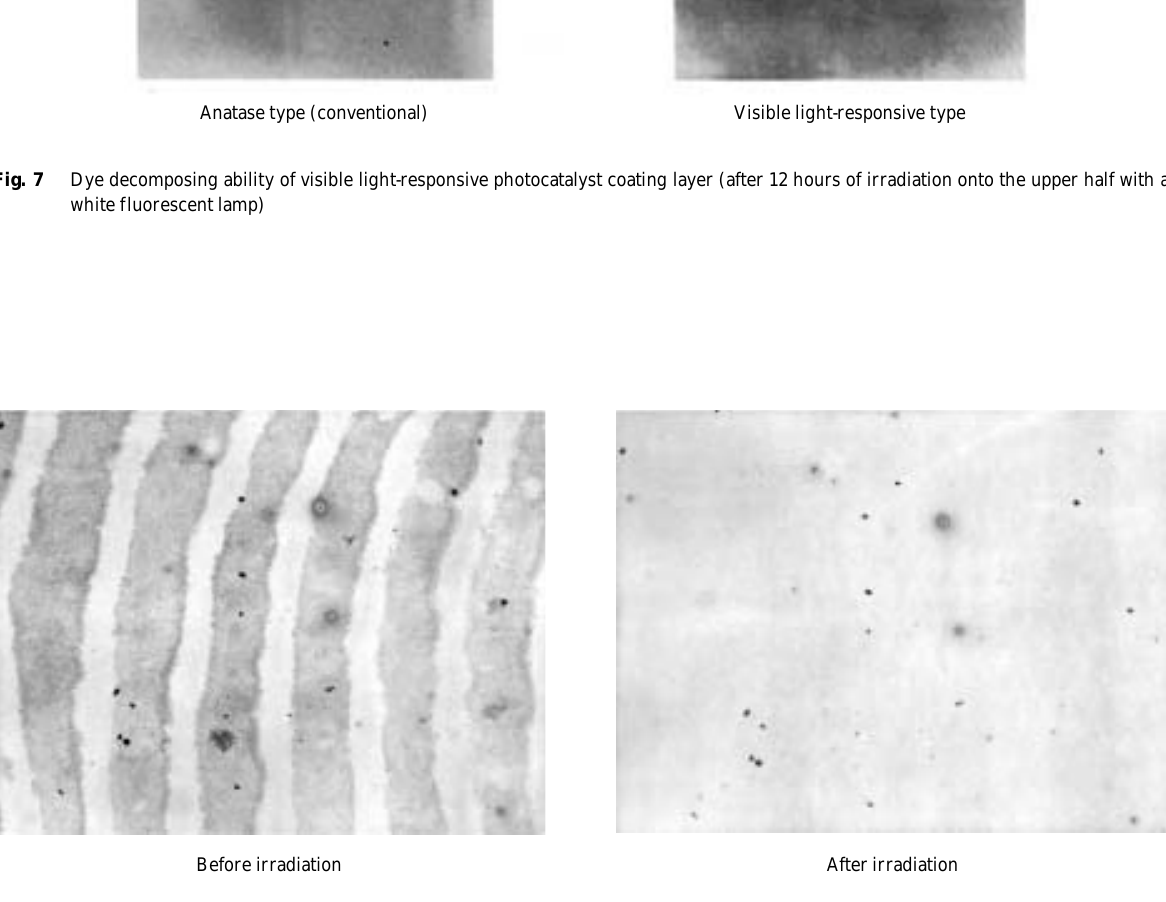
Fingerprint decomposing ability of visible light-responsive photocatalyst Evaluated with an optical microscope [magnifying power: (cid:4) 50] Substrate: glass (12 hours of irradiation with a white fluorescent lamp, 3,000